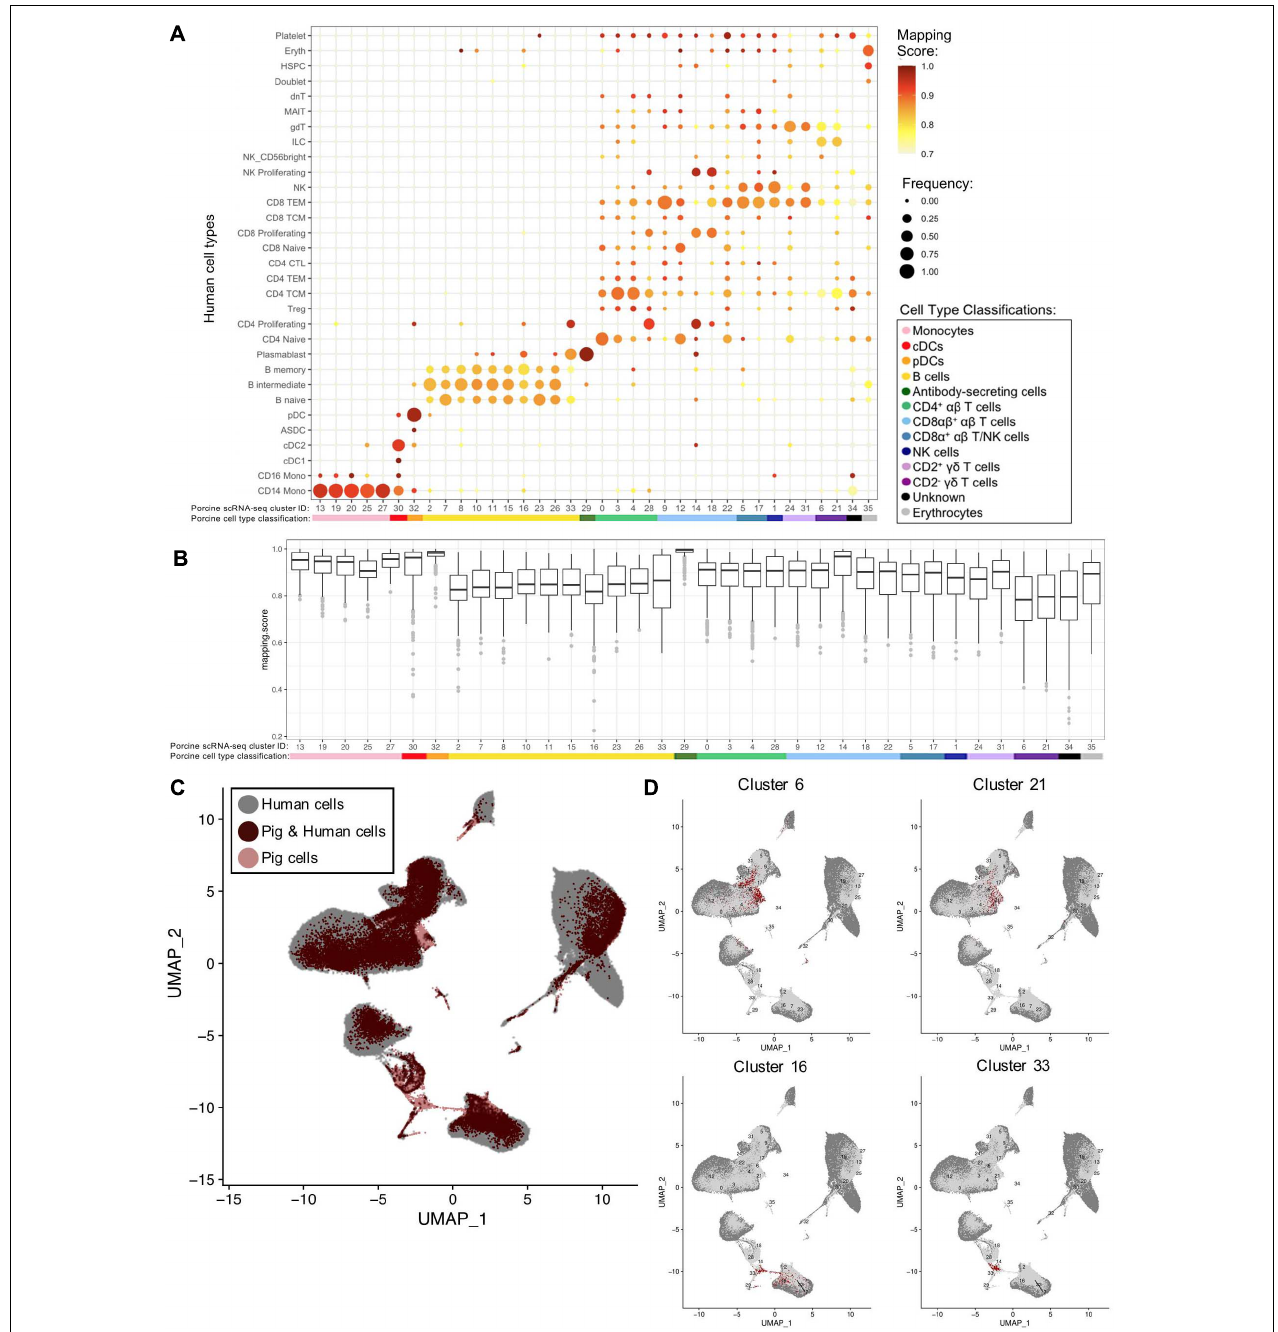
FIGURE 6 | Integration of porcine and human scRNA-seq datasets to further annotate porcine cells. (A) Mapping scores calculated to determine how well porcine cells were represented by the human dataset. The human cell type specific frequency (size of the circle) and mapping score for that human cell type (color) are shown for each porcine scRNA-seq cluster. Porcine cell type classifications (color) are shown below the porcine scRNA-seq cluster IDs. (B) Mapping scores calculated to determine how well porcine cells were represented by the human dataset. The mapping scores for each porcine scRNA-seq cluster is represented by a box and whiskers plot. Porcine cell type classifications (color) are shown below the porcine scRNA-seq cluster IDs. (C) To identify cells in the porcine dataset that were not well represented in the human dataset, a de novo visualization of the merged porcine and human data was performed. The porcine (pink) and human (gray) were plotted together using UMAP. An overlap of both porcine and human cells is shown as (dark red). Clusters of porcine cells that are not well represented in the human data can be observed by pink regions in the plot. (D) Two primary regions of porcine cells that were not well represented in the human data were identified in (C) . In order to clarify which porcine scRNA-seq clusters were represented in these regions, the porcine cluster IDs were projected onto the UMAP and cells from four clusters overlapping the identified regions were colored as dark red.